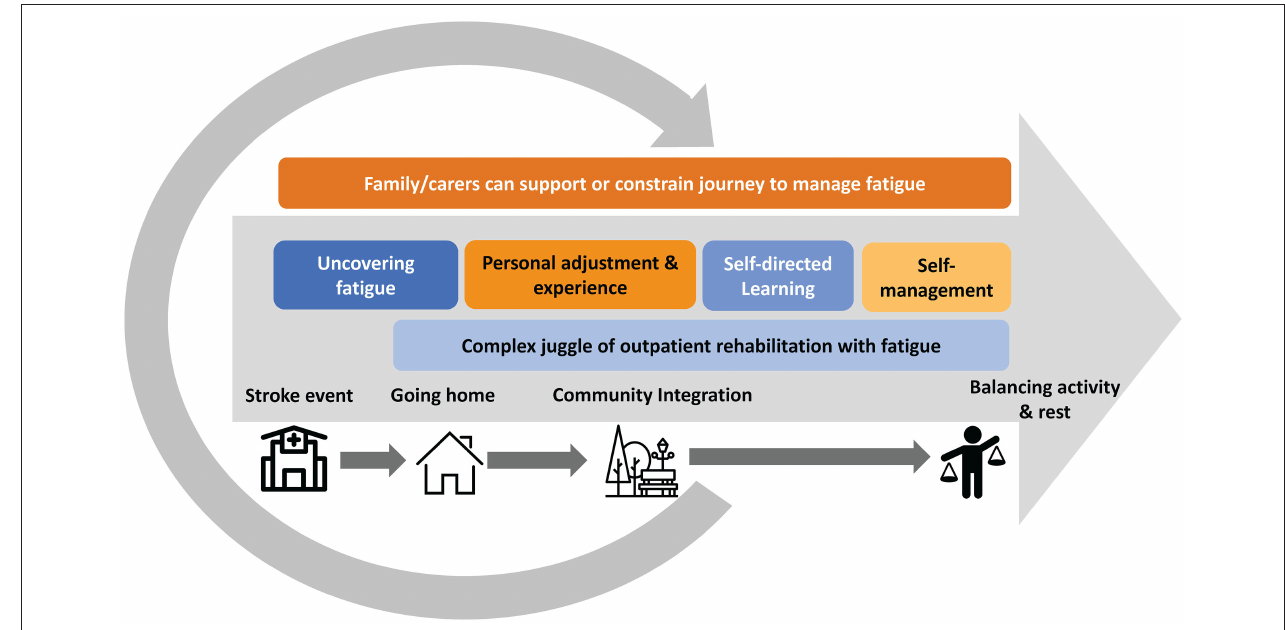
FIGURE 3 | Figurative representation of the experience of post-stroke fatigue during outpatient rehabilitation. The six themes are presented in a timeline from stroke onset, time in hospital, discharge home and integration into the community. Themes 1, 2, 3 and 5 have chronological attributes. Theme 1—The unpredictable and unprepared uncovering of fatigue is first experienced when returning home, Theme 2—Experience and adjustment are personal represents the next phase where stroke survivors are grappling with adjustment prior to learning more about fatigue and engaging in self-management; Theme 3—Being responsible for self-managing fatigue and Theme 5—Learning about fatigue is a self-directed problem-solving experience . Theme 4—The complex juggle of outpatient stroke rehabilitation with fatigue coincides with the above, commencing once home and starting outpatient rehabilitation, and Theme 6—Family and carers can support or constrain managing fatigue is presented outside the timeline, and overlapping, as it had an influence on all other